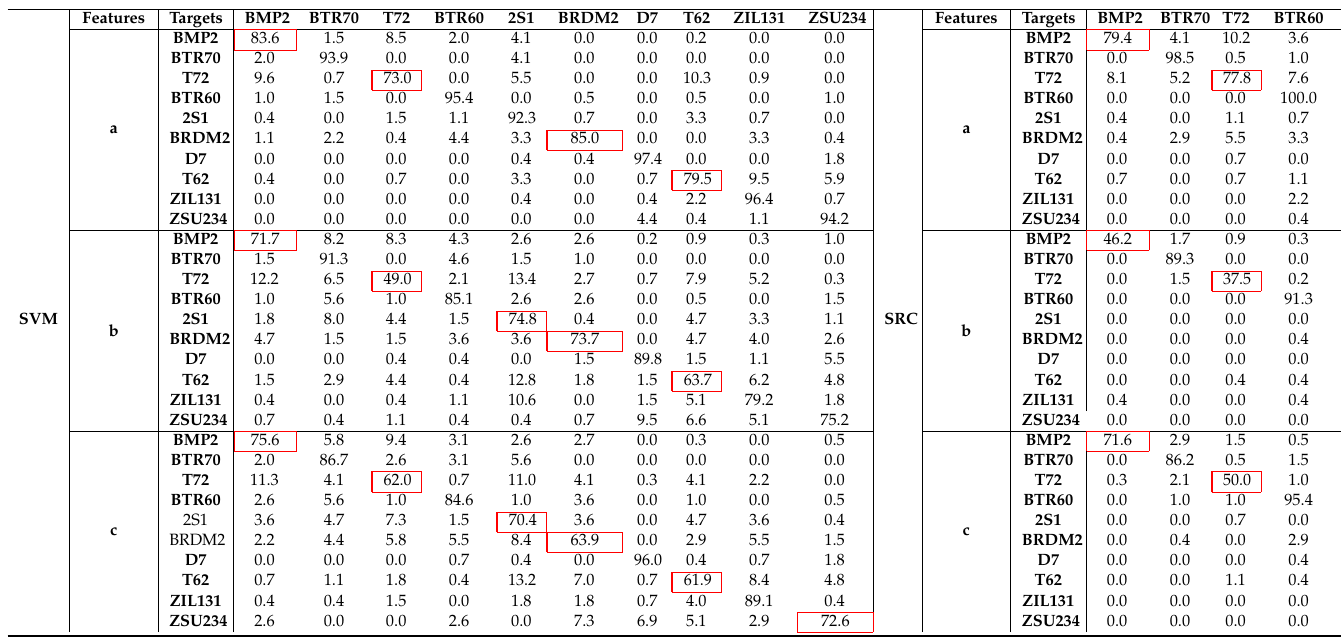
Table 4. The 10-class target confusion matrices of two classifiers under different feature